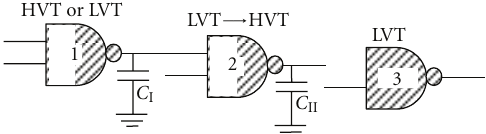
Figure 7: Situation of the LVT cell exchanged for the calculation of limSlew